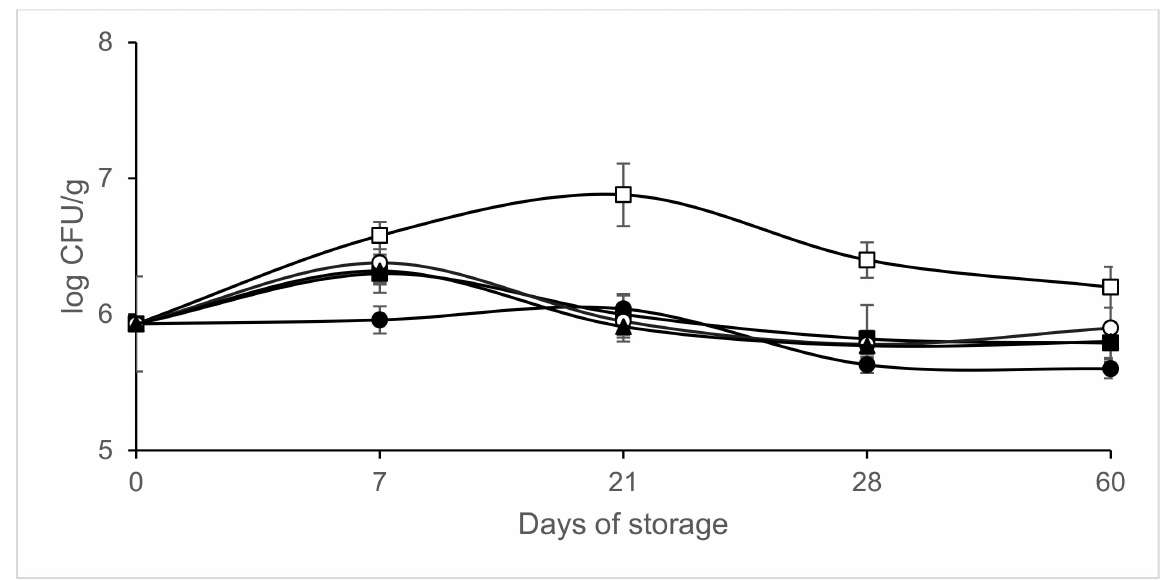
), 40% CO 2 /60% N 2 ( (cid:78) ). (cid:35)